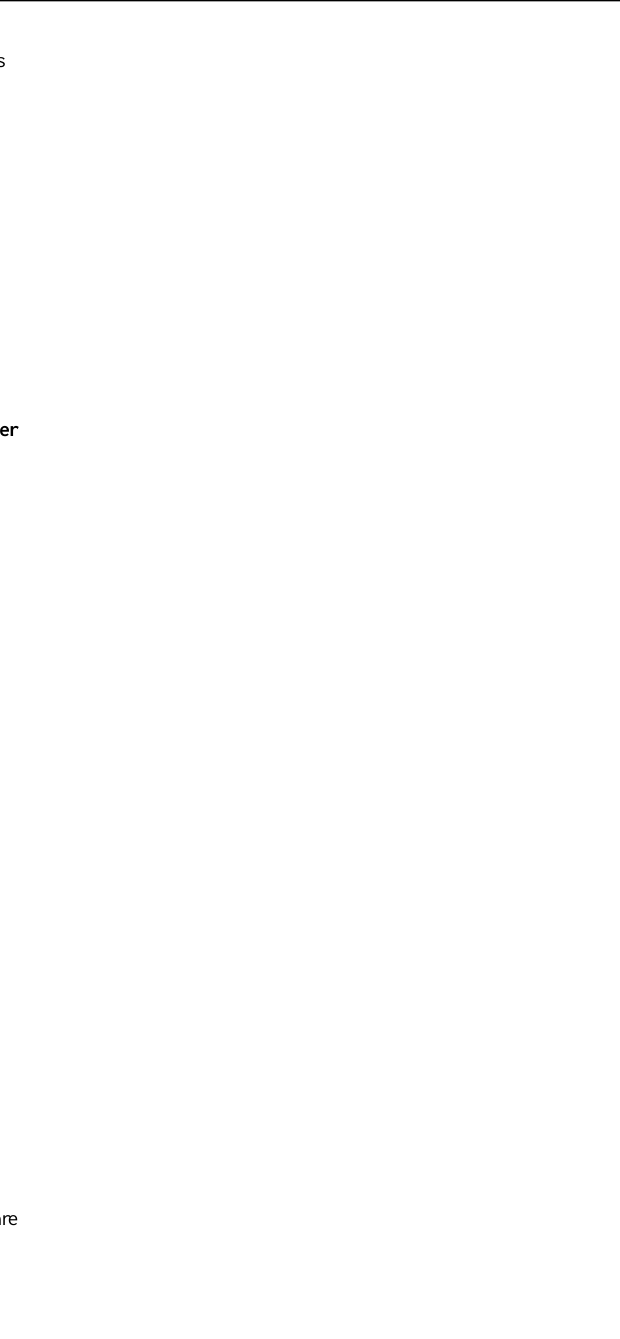
Textbox 1. Themes and